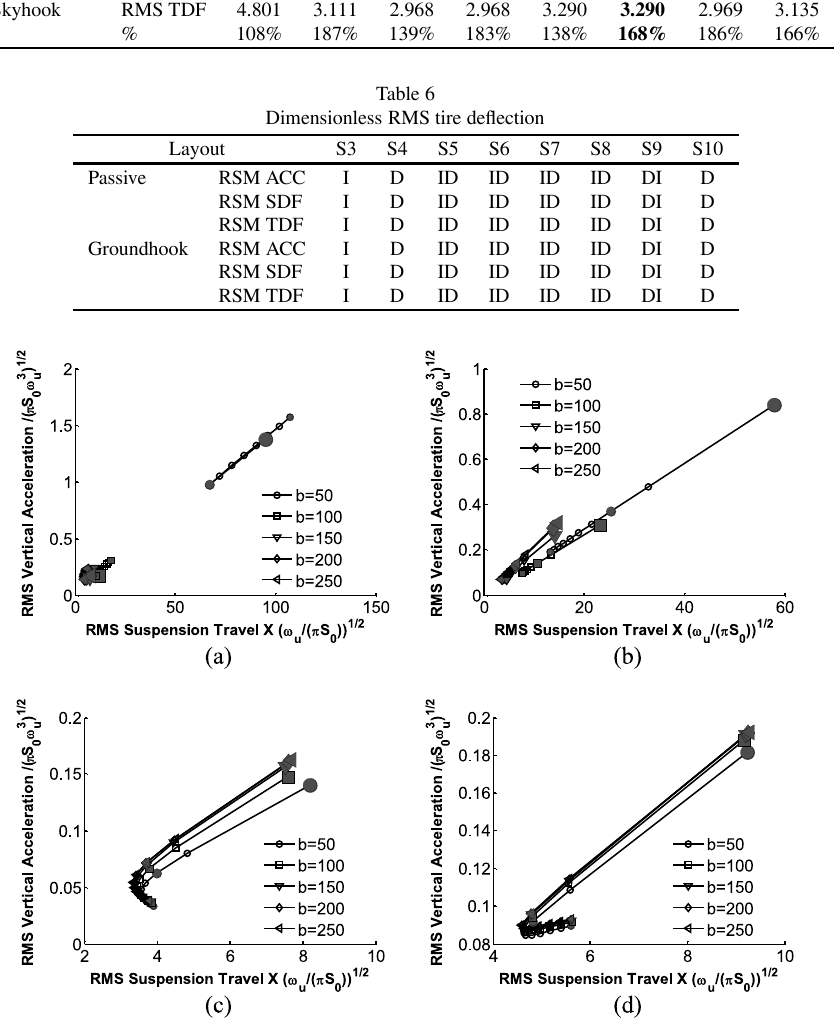
Fig. 6. Relationship between RMS acceleration and RMS suspension travel with layout s8 (effect of inertance and damping): (a) Passive; (b) Groundhook; (c) Hybrid; (d)Skyhook. 49%, RMS suspension travel decreased 36% and RMS tire de fl ection decreased 22%. The performance comparison of all layouts is tabulated in Table 3 to Table 5. Damping ratio is fi xed at 0.26, r k is 10 and other parameters are from Table 2. Note that the RMS ACC is the dimensionless RMS of sprung mass vertical acceleration; RMS SDF is the dimensionless RMS of suspension de fl ection, and RMS TDF is the dimensionless RMS of tire de fl ection. The comparisons of these results show that for Layout s3 to Layout s10, using the Hybrid control method results much better performance than the passive suspension with same